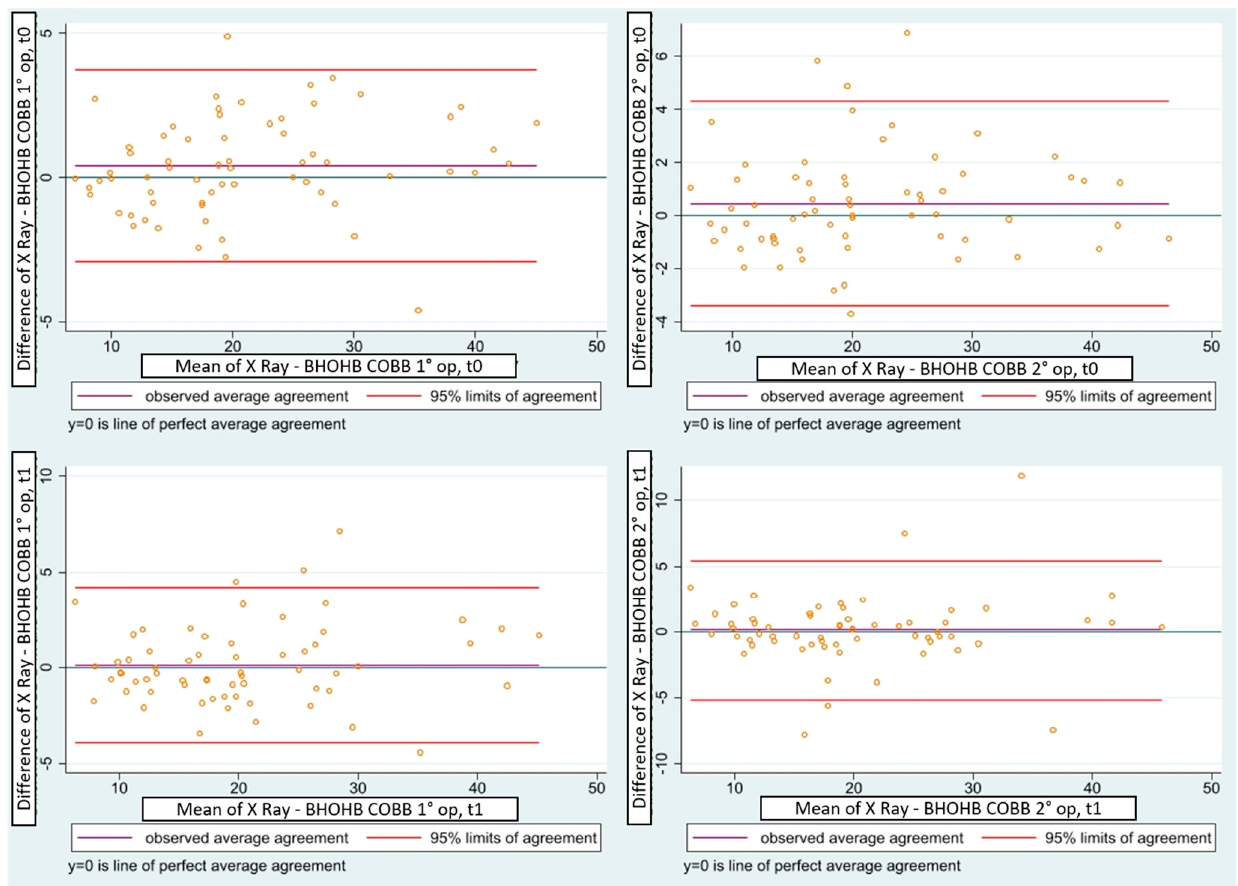
Figure 6. Concordance correlation confidence (Lin 1989–2000) between Cobb and BHOHB for the first and second operators in t0 and t1.